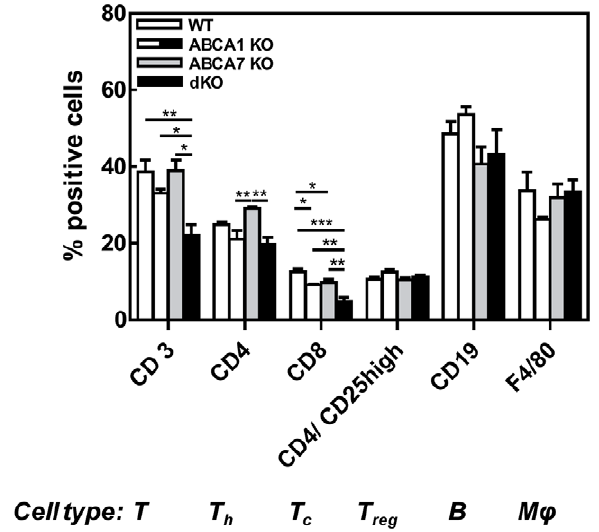
Figure 8. Effects of single macrophage ABCA7 and combined macrophage ABCA1 and ABCA7 deficiency on cellular spleen composition. Spleen cell subsets measured by flow cytometry expressed as percentage of positive cells. Values represent the mean 6 SEM of 5 mice per group. Statistically significant difference *p , 0.05, **p , 0.01 and ***p , 0.001.